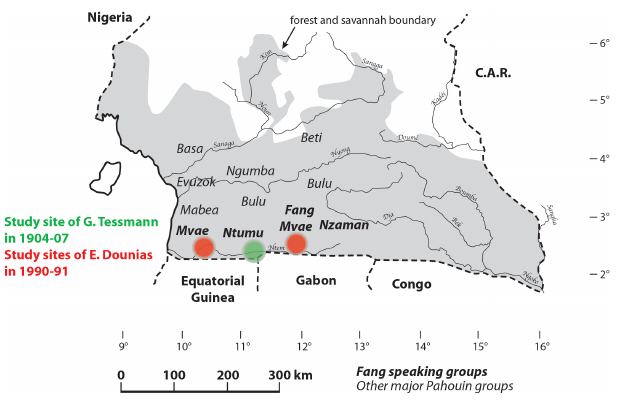
Fig. 1 . Fang populations and study areas in